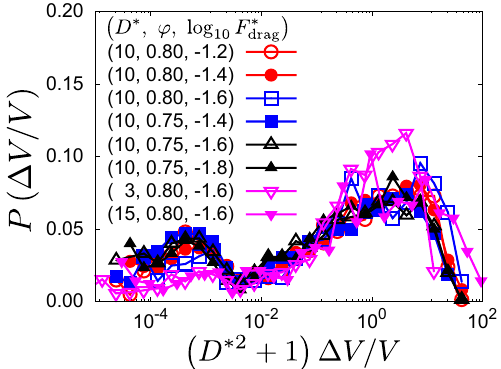
Figure 7. Probability distribution of the velocity drops for var- ious D , ϕ , and F drag , where V is the steady speed of the object (see Fig. 2) and we have introduced D ∗ ≡ D / d